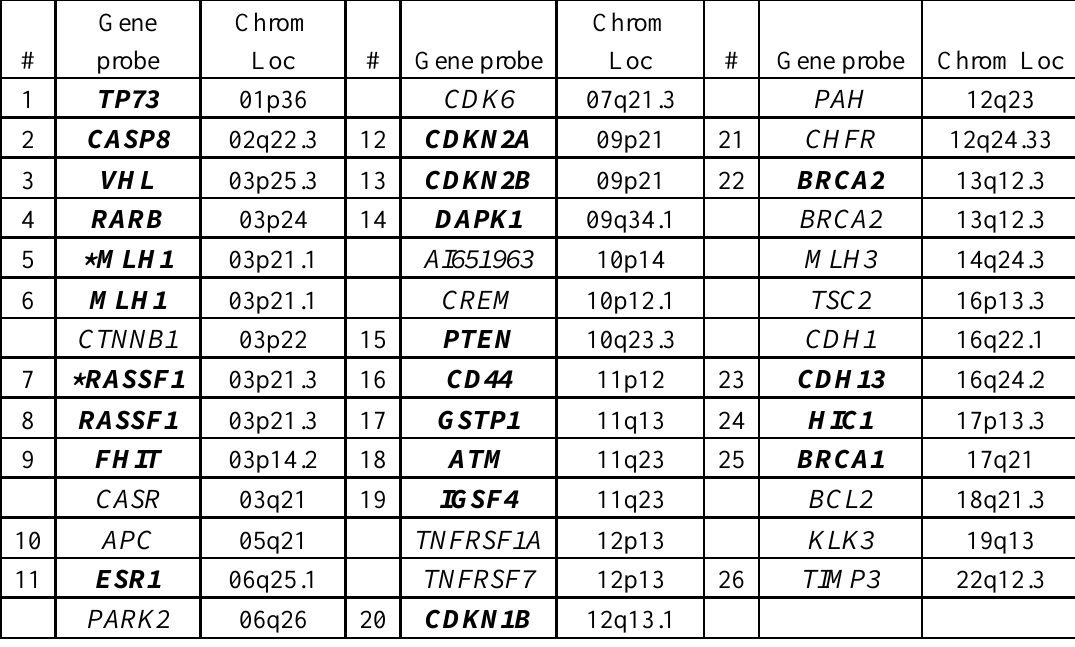
Table 2. Methylation-Specific MLPA Probe Panel (ME001).